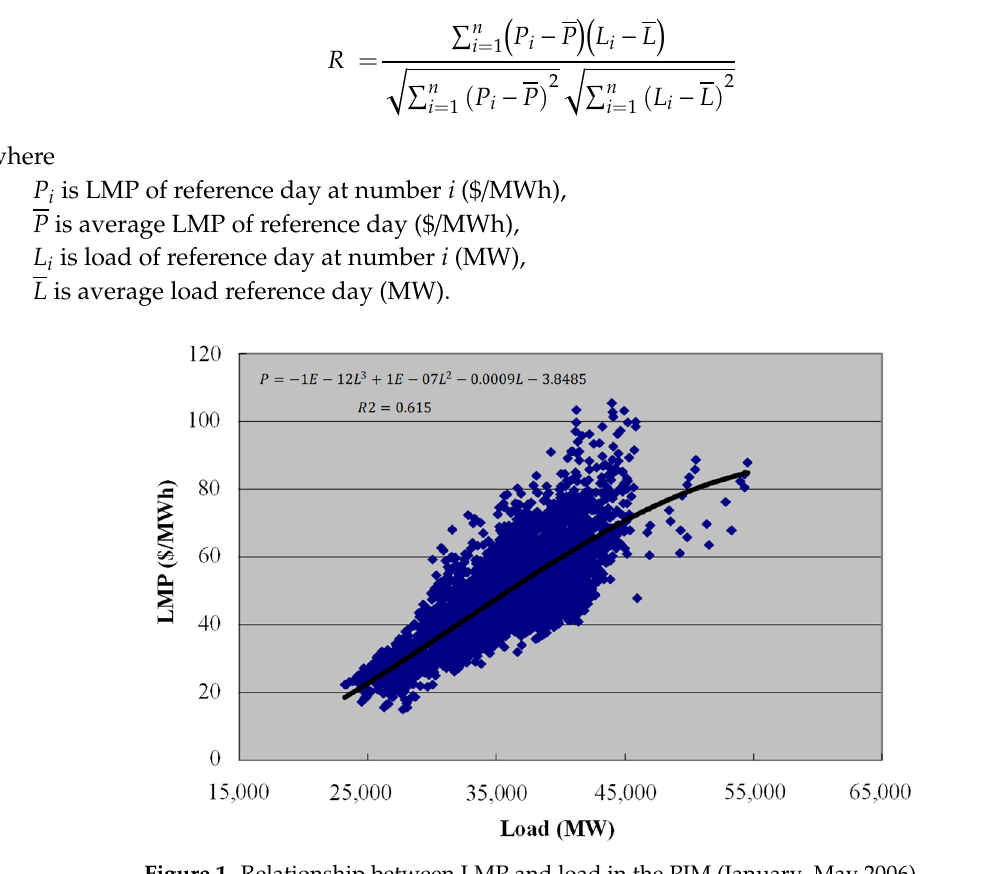
Figure 1. Relationship between LMP and load in the PJM (January–May 2006).